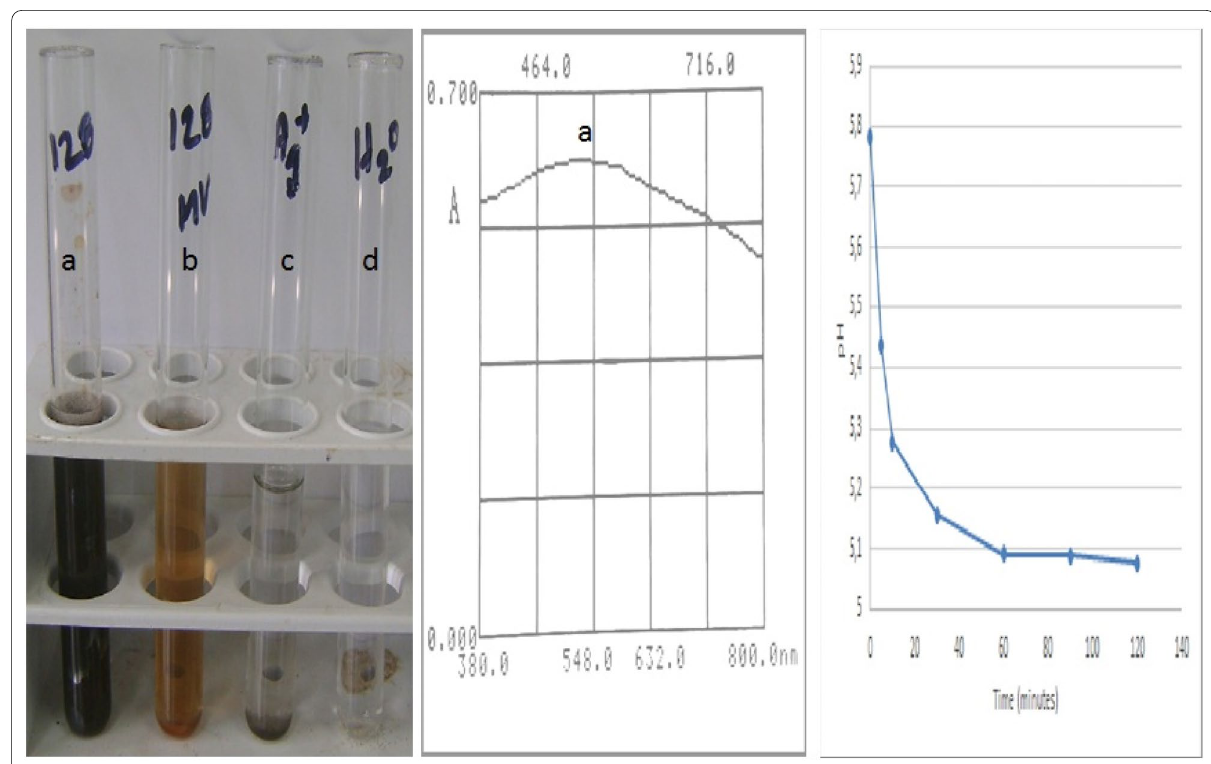
Fig. 3 Identification of the formation of SNP from Leea coccinea . Visual ( a ), spectrophotometric ( b ) and pH variation during bio-reduction ( c ). a: positive reaction between aqueous extract of leaves (AEL): silver solution 2 mM (1:9) (V/V); b: negative reaction of AEL: distilled water (1:9); c: silver solution 2 mM: distilled water (9:1); d: distilled water